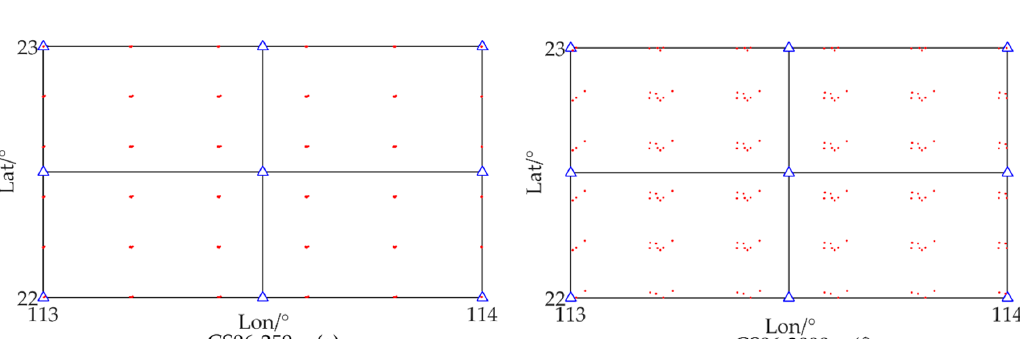
Figure 9. Horizontal cross-section at ( a ) 250 m layer in CS04; ( b ) 2000 m layer in CS04; ( c ) 250 m layer in CS05; ( d ) 2000 m layer in CS05; ( e ) 250 m layer in CS06; ( f ) 2000 m layer in CS06. Triangles denote the to-be-estimated grid nodes. Black dots represent the puncture points of GNSS signals.